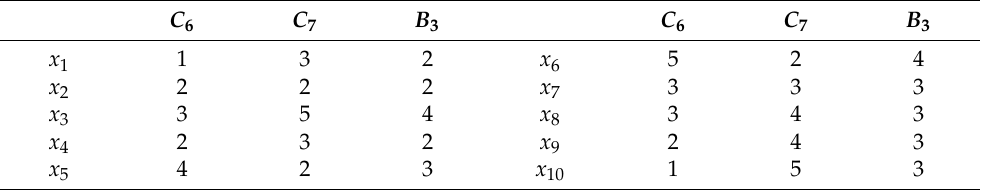
Table 5. Sample data discretization of index